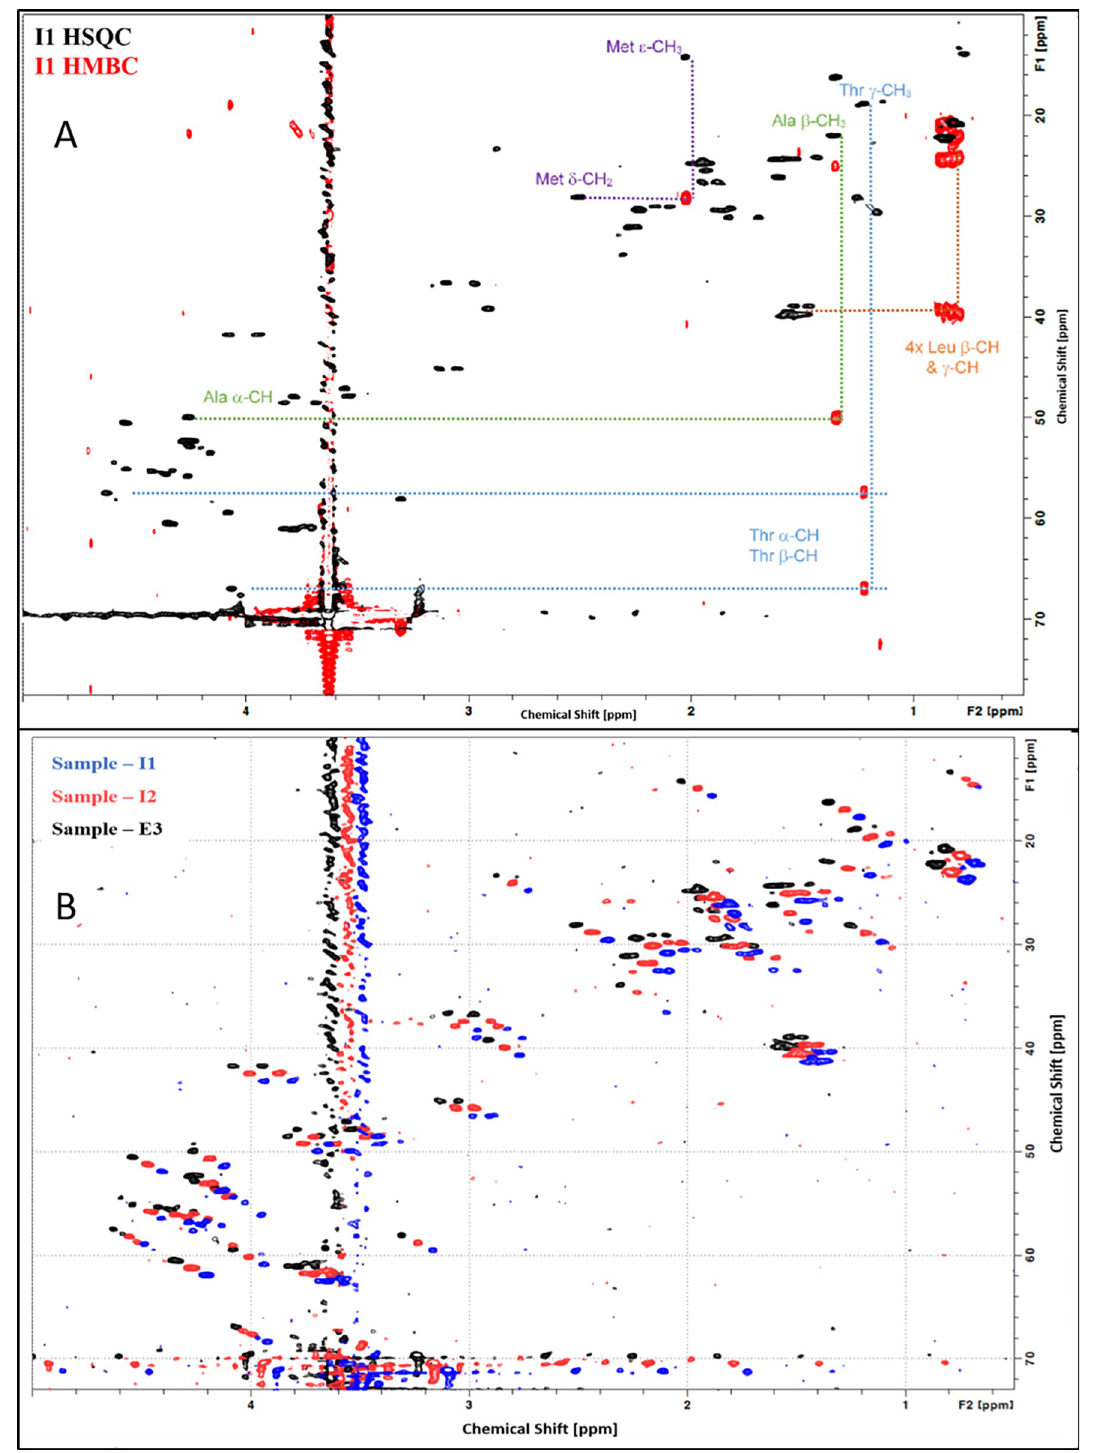
Fig 5. (A) Overlay of 1 H- 13 C HSQC and HMBC spectra for INTP5 (Sample I1), N-terminal peptide; (B) Shifted overlay of 1 H- 13 C HSQC spectrum for INTP5 (Sample I1, Sample I2) and EU sourced Neulasta (Sample E3).